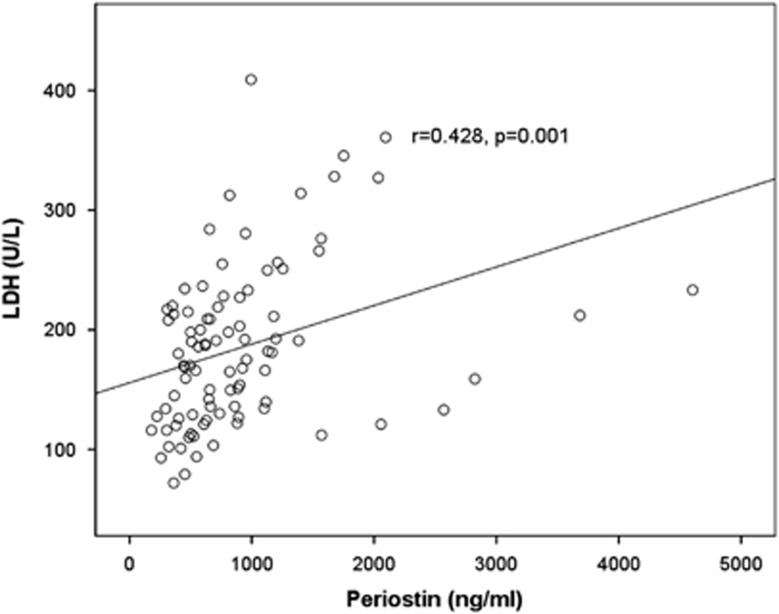
Serum levels of periostin strongly correlate with serum LDH (a marker of advanced disease).